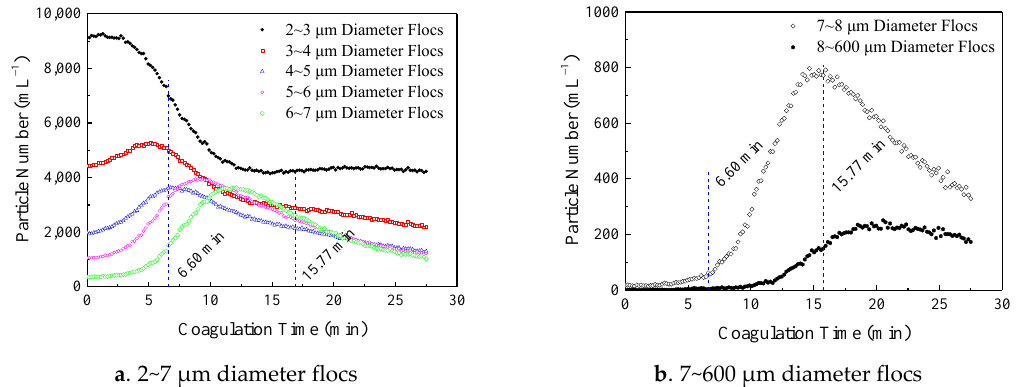
Figure 6. Change in the number of each size of floc in the three stages. ( a ) The number of flocs with a diameter of 2~3 μm, 3~4 μm, 4~5 μm, 5~6 μm, and 6~7 μm; ( b ) the number of flocs with a diameter of 7~8 μm and 8~600 μm.